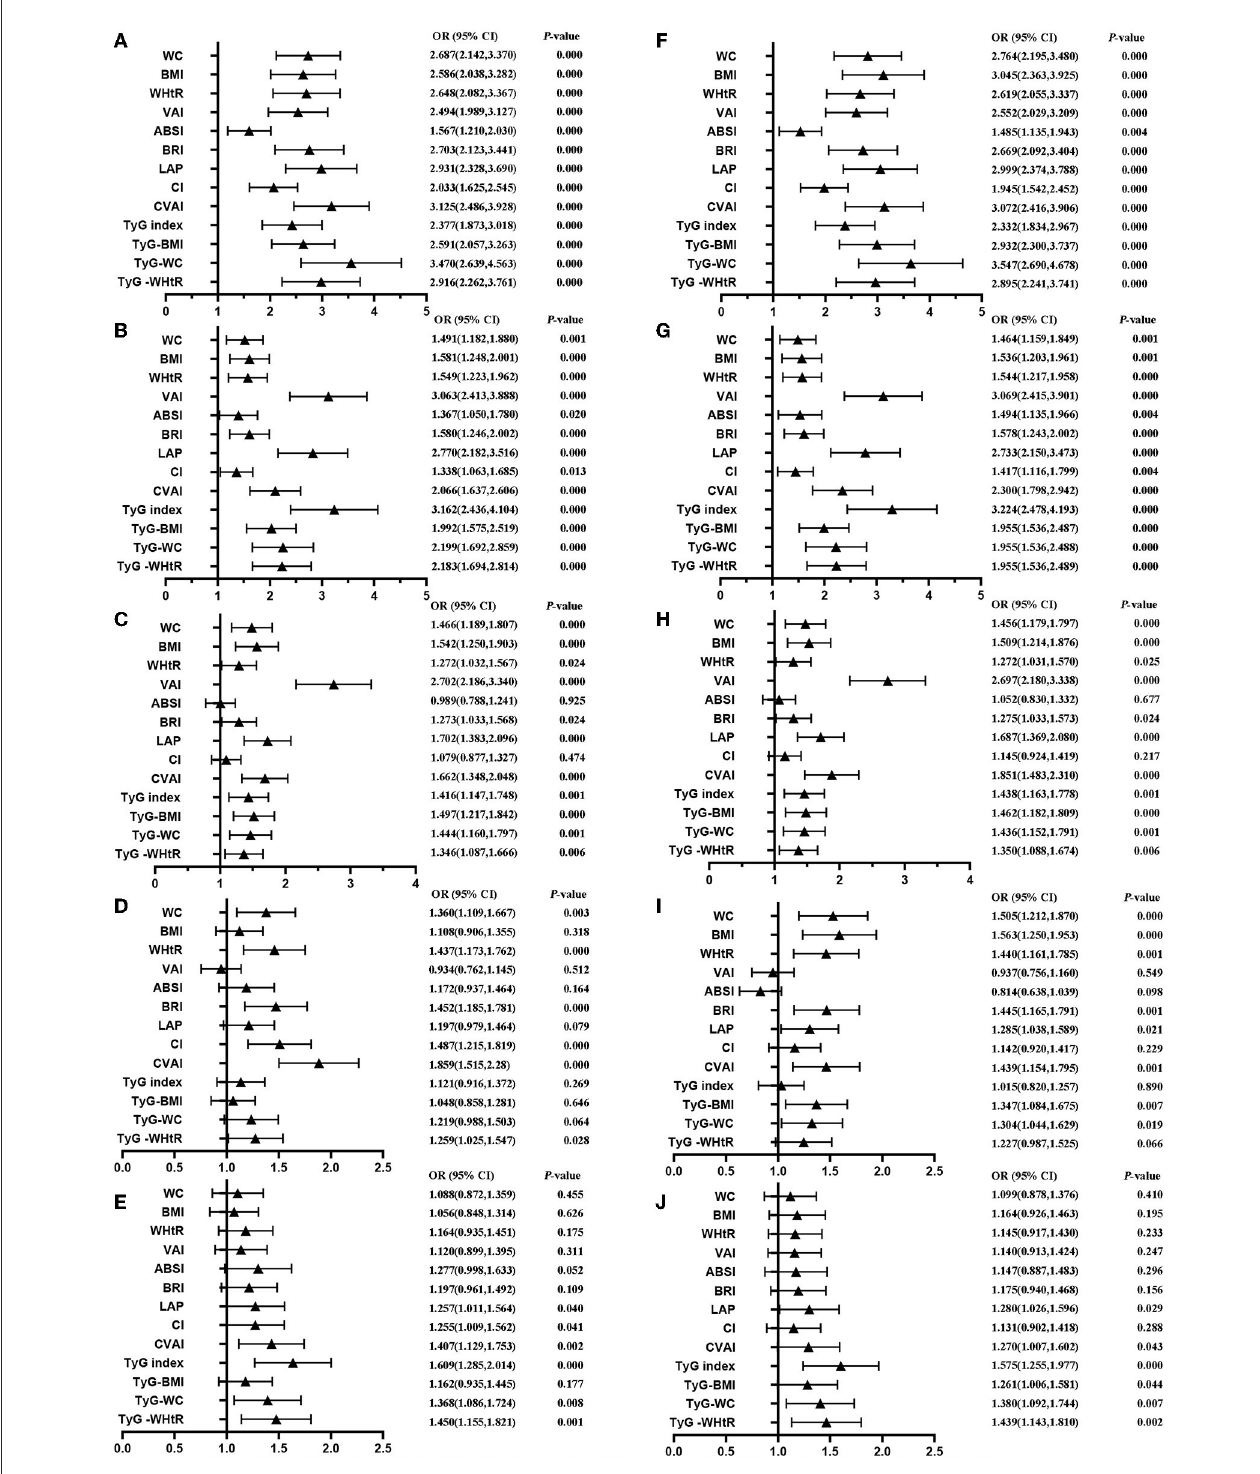
FIGURE6 Forest diagram of OR before and after adjustment of confounding factors for female. (A) Mets unadjust, (B) Elevated triglycerides unadjusted, (C) Reduced HDL-C unadjusted, (D) Elevated blood pressure unadjusted, (E) Elevated fasting glucose unadjusted, (F) Mets adjusted, (G) Elevated triglycerides adjusted, (H) Reduced HDL-C adjusted, (I) Elevated blood pressure adjusted, (J) Elevated fasting glucose adjusted. Adjusted OR: Adjusted for age, educational levels, marital status, live place, current smoking, alcohol drinking, activities, exercises, chronic